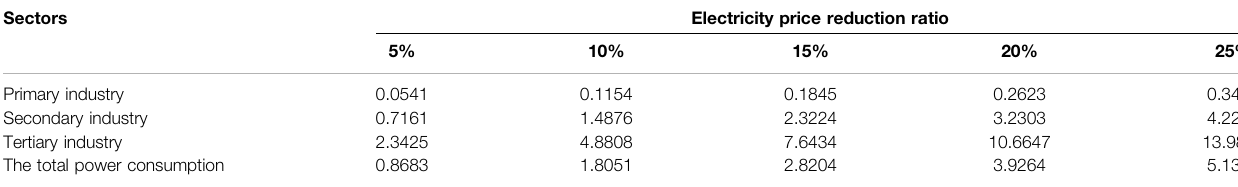
TABLE 4 | Impact of general industrial and commercial electricity price reduction on the electricity consumption of sectors (%).